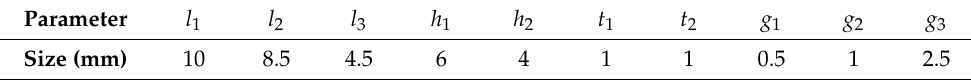
Figure 2. ( a ) Unit cell dimension for patch, ( b ) equivalent circuit. Table 1. Dimension of the continuous, dual, and opposite P-shaped spiral resonator.